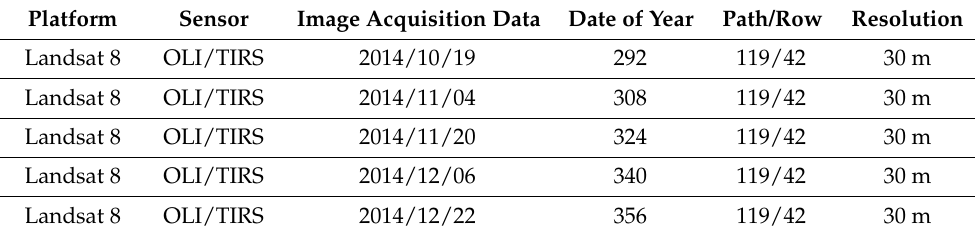
Table 1. Description of Landsat data used in this study. Platform Sensor Image Acquisition Data Date of Year Path/Row